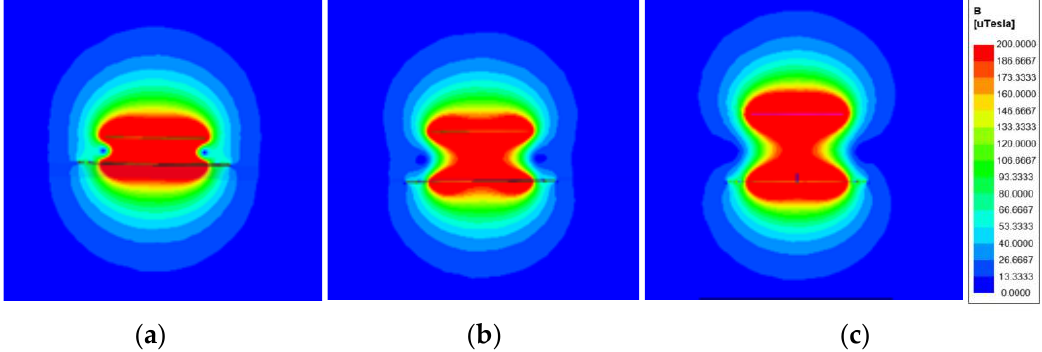
Figure 11. The magnetic flux density distribution of WPT system with double-coil active shielding: ( a ) 50 mm; ( b ) 100 mm; ( c ) 150 mm.